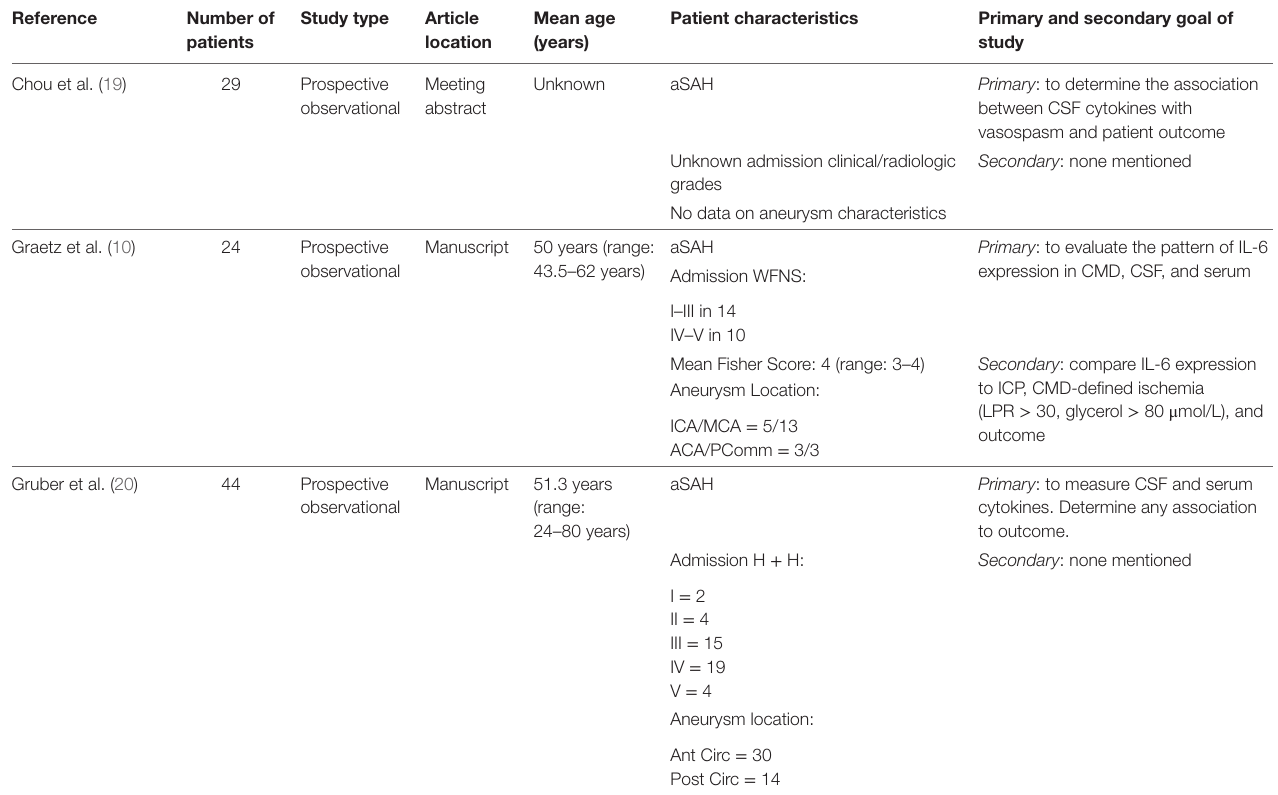
TABLe 2 | CSF cytokine study characteristics and patient